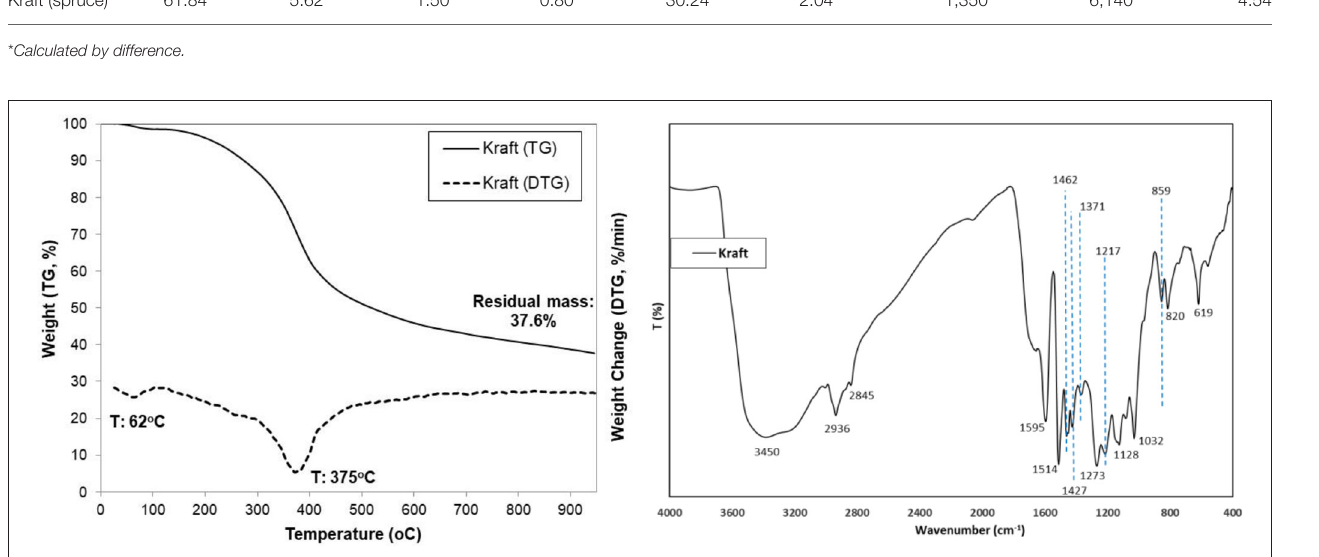
substituted aromatic rings of the kraft lignin units. The spectrum is predominated by the strong signals of guaiacyl (G) units at C2– H2 ( δ C/ δ H 109.5-112.8/6.7–7.2 ppm), C5–H5 ( δ C/ δ H 115.3/6.8 ppm), and C6–H6 ( δ C/ δ H 118.7–121.8/6.5–7.3 ppm). The